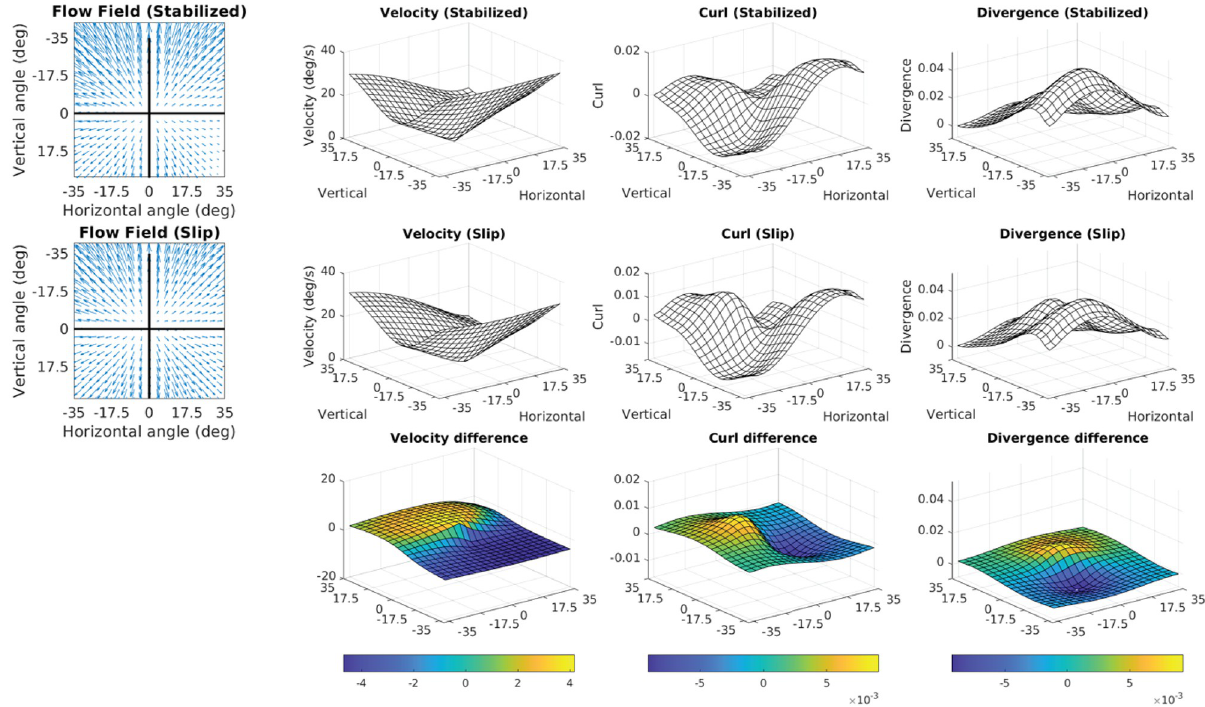
Fig 9. A representative flow field during a perfect 250ms fixation (stabilized) and when undergoing 1 degree of slip. An eye translation direction downwards and slightly to the left of fixation is examined. The top row shows the stabilized case (i.e. perfect fixation) and the second row shows the unstabilized case (i.e. retinal slip). The bottom row shows the difference between the two, calculated by simple subtraction. The two plots on the left show the flow fields for the stabilized and unstabilized cases, and are very similar qualitatively, with the focus of expansion slightly shifted in the opposite of motion slippage. The plots on the right are centered on the fovea, and show velocity fields, curl, and divergence values. During stabilization, velocities are low with 0 deg/s at the fovea due to simulated perfect fixation. For stabilization with slip, velocity at the fovea is 4.17 deg/s and velocities at other retinal locations are shifted either higher or lower depending on location, however the magnitude of this shift does not exceed the foveal slip. There are small changes in the curl and divergence fields but the patterns are very similar.